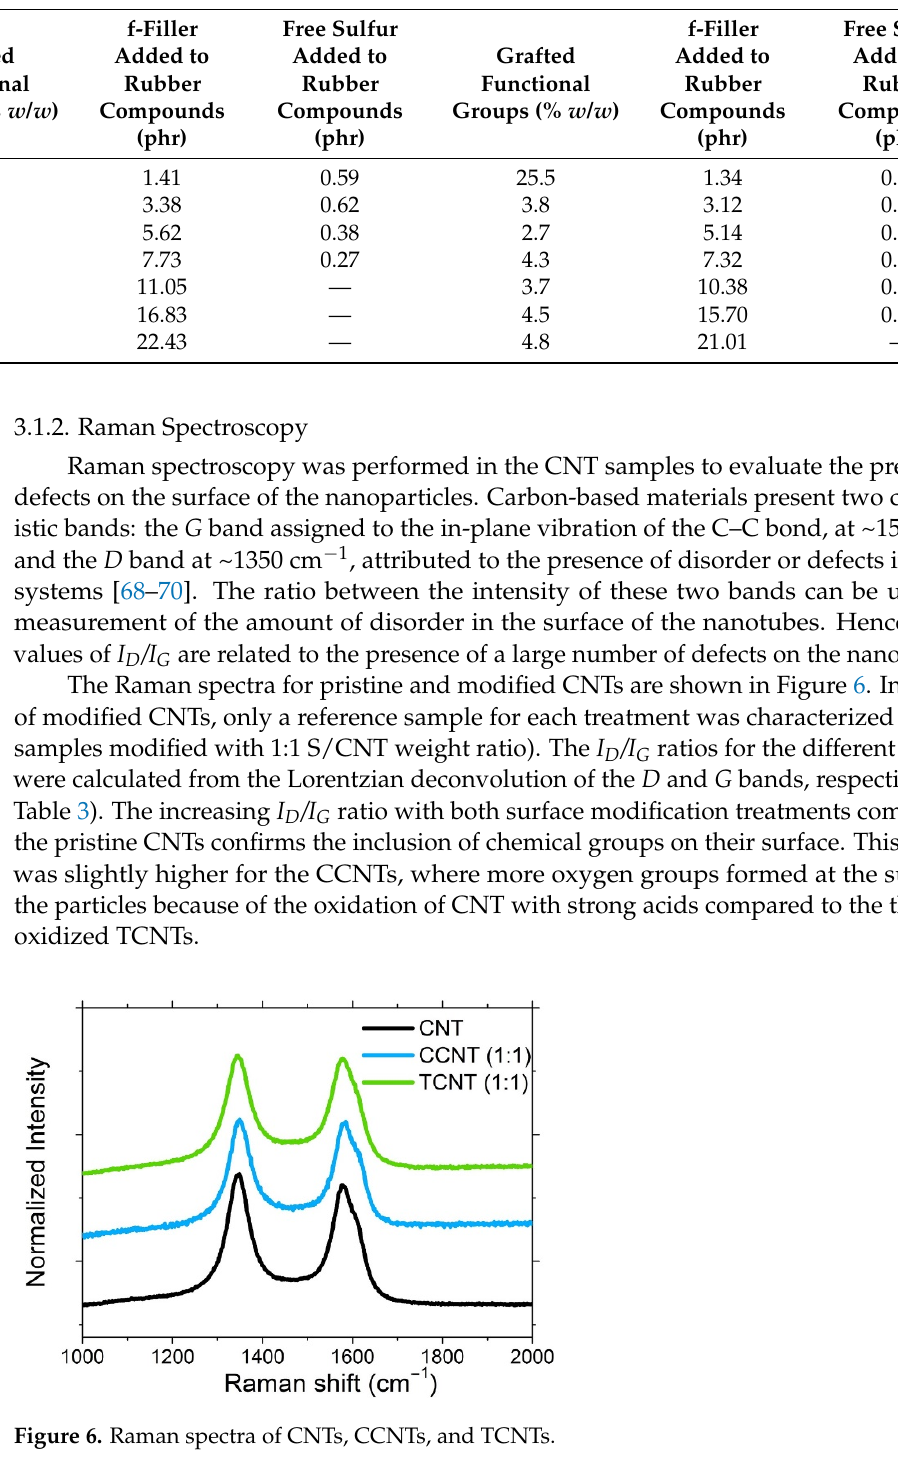
Table 2. Fraction of functional groups grafted in the CNT surface according to the S/CNT weight ratio used in the functionalization reaction. Amount of functionalized filler and free sulfur added to the rubber compounds to keep the fraction of CNTs constant.